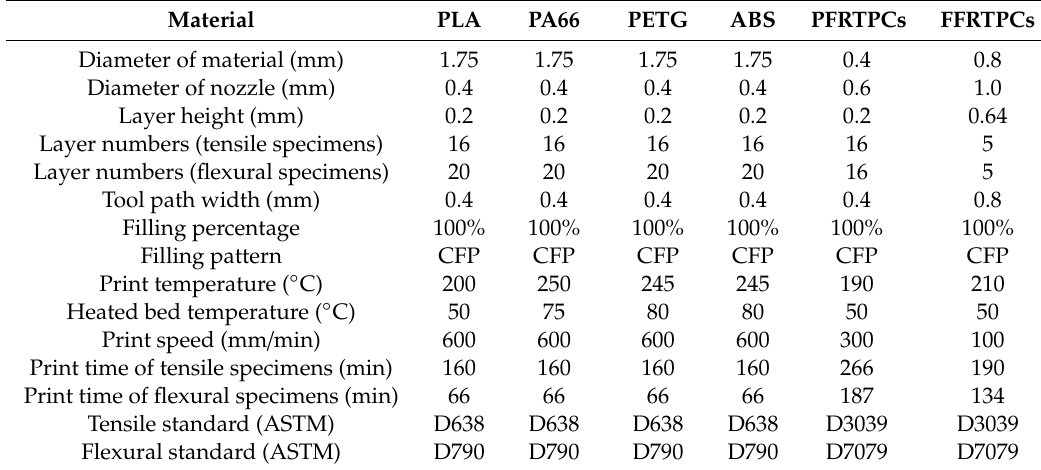
Table 2. The printing parameters of specimens.